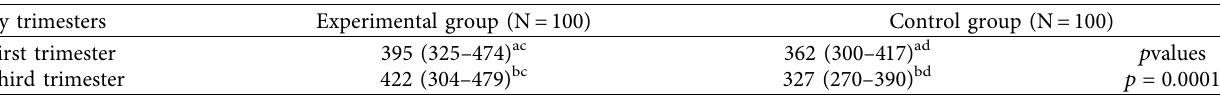
Table 5: Median urinary iodine concentration (UIC) ∗ mcg/L in the experimental and control groups in the frst and third trimesters. By